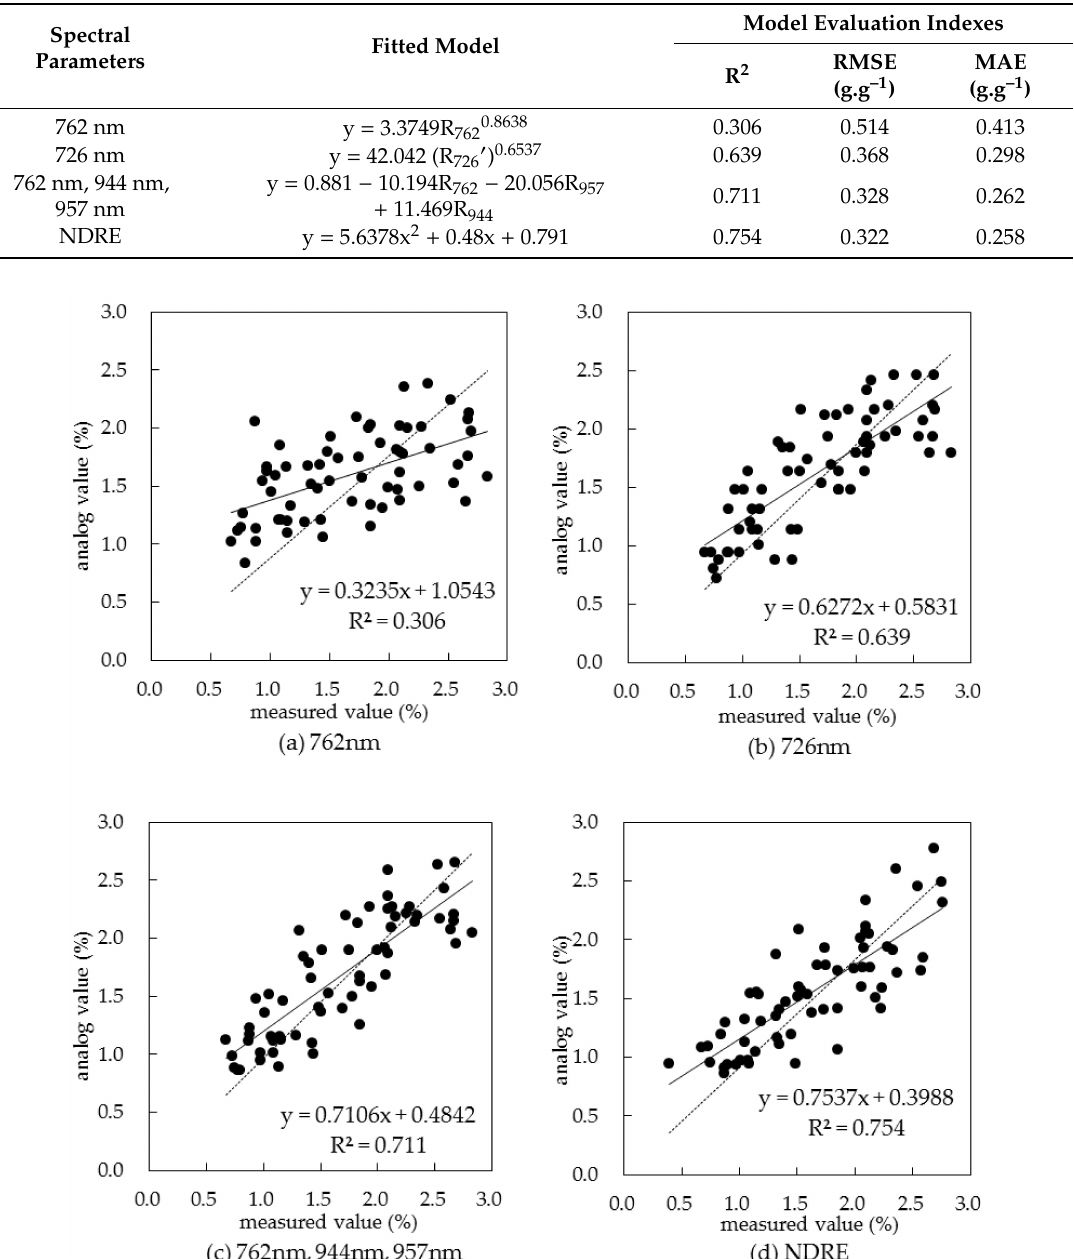
Table 9. Evaluation of indexes of the fitting models during the whole growth period.